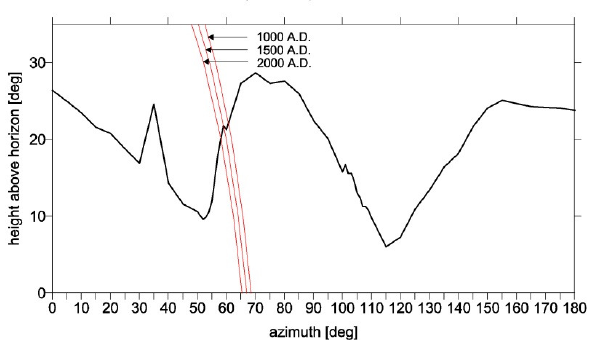
Figure 4: The rise of Pleiades in epochs 1000, 1500 and 2000